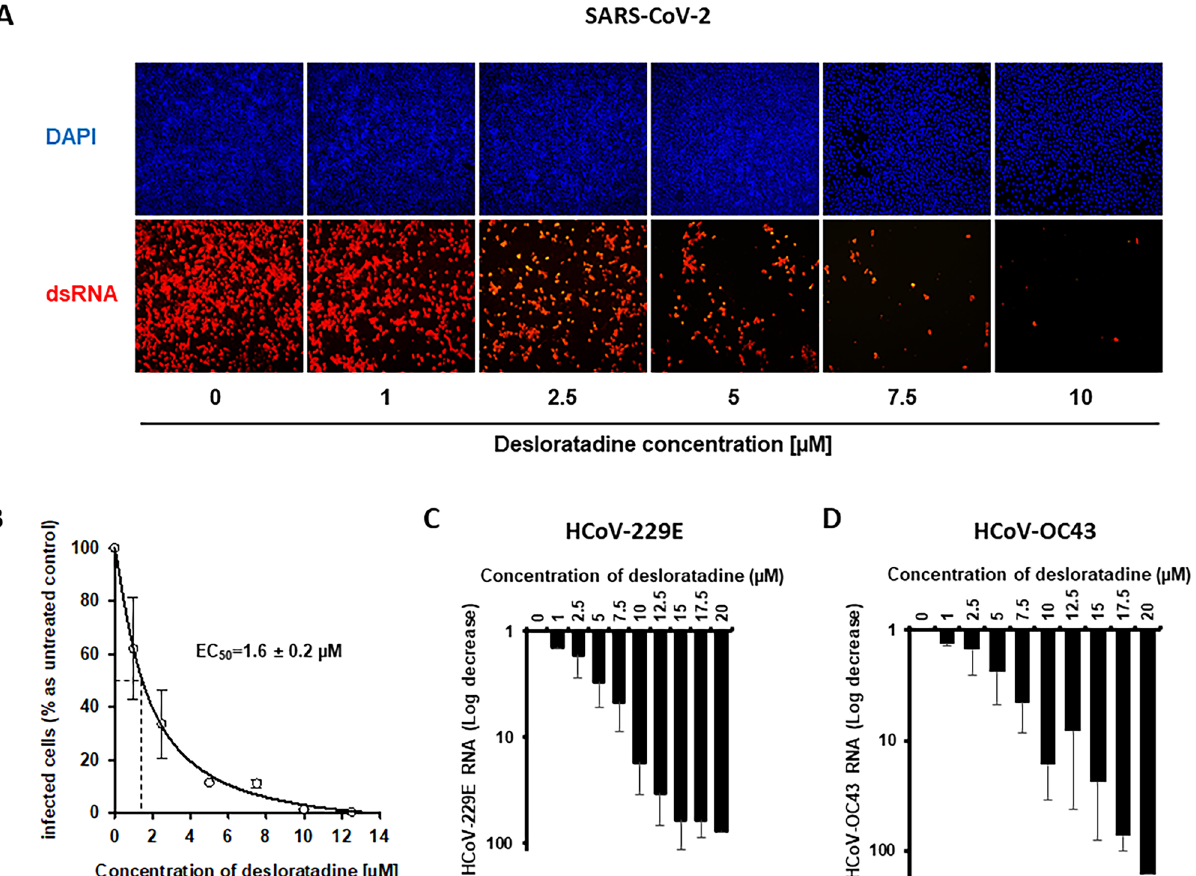
Figure 3. Assessment of desloratadine antiviral activity against SARS-CoV-2, HCoV-229E and HCoV-OC43. Vero-E6, MRC-5 and HRT-18 cells were infected with SARS-CoV-2 (MOI = 0.2), HCoV-229E (MOI = 0.5) and HCoV-OC43 (MOI = 0.5), respectively, and treated with increasing concentrations of desloratadine. ( A ) SARS-CoV-2 infection of Vero-E6 cells monitored by immunofluorescence with an antibody directed against double stranded RNA (dsRNA). ( B ) SARS-CoV-2-infected Vero-E6 cells quantified by image J software. Effect of increasing concentrations of desloratadine on HCoV-229 ( C ) and HCoV-OC43 ( D ) viral RNA production in MRC-5 and HRT-18 cell supernatants, respectively, quantified by respectively 24 (Fig. 4F). 10 µM of E64D and camostat were used as controls. E64D alters viral fusion at the endo- some membrane through inhibition of the endosome-resident cysteine proteases cathepsins, whereas camostat alters viral fusion at the plasma membrane by inhibiting the cell surface serine protease TMPRSS2. As expected, camostat significantly inhibited SARS-CoV-2 infection in Calu-3 cells, whereas it was less effective in Vero-E6 cells. Conversely, E64D effectively reduced SARS-CoV-2 infection in Vero-E6 cells, whereas no significant inhi- bition was observed in Calu-3 cells with this compound. The effect of desloratadine was similar to that of E64D, i.e. potently inhibitory against SARS-CoV-2 infection in Vero-E6 cells, but not in Calu-3 cells. These findings indicate that desloratadine blocks SARS-CoV-2 entry via the endosomal route.